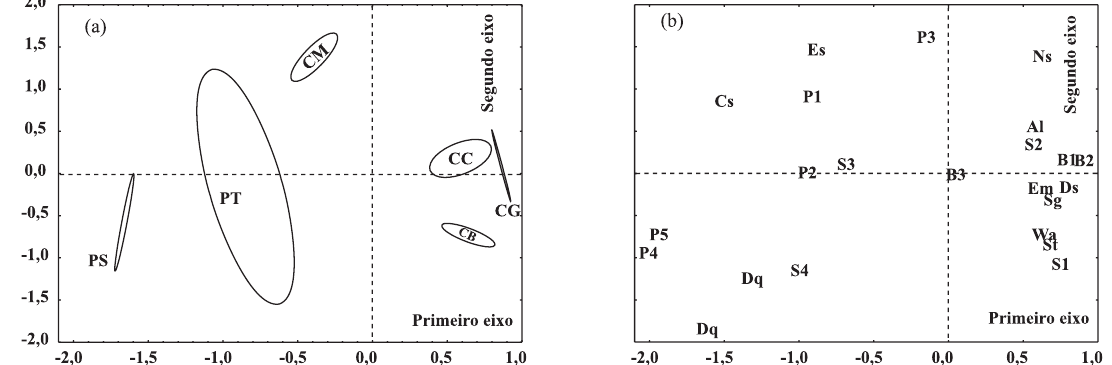
Figura 5. Análise de correspondência canônica: diagramas de ordenação mostrando a distribuição dos 18 sítios de restinga (a) e de 22 espécies de formiga capturadas nas armadilhas de solo (b) nos dois primeiros eixos. Valores dos vetores dos atributos de solo usados (17 variáveis) estão no quadro 5. Grupos de sítios em (a) como elipses: CM: Caju, mata; CG: Caju, capim-gengibre; CB: Caju, coqueiral do banco de germoplasma; CC: Caju, capoeira; PT: Pirambu, mata de topo; PS: Pirambu, mata de sopé. Espécies de formigas representadas por códigos do quadro 4 em